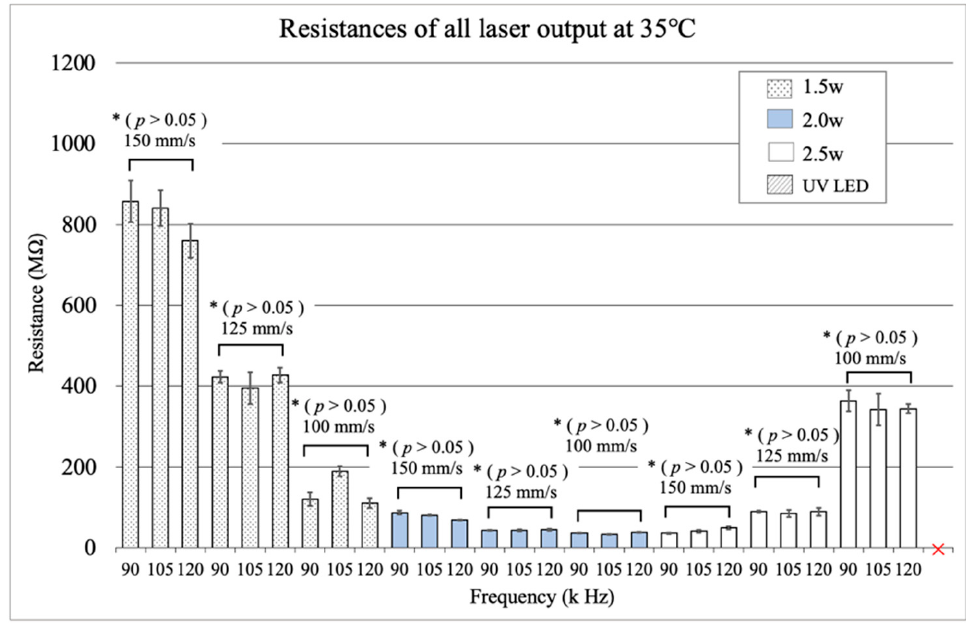
Figure 6. Resistance experimental results of all laser parameters that were measured at 35 ° C and compared with furnace 260 ° C calcination process (far right in each chart).